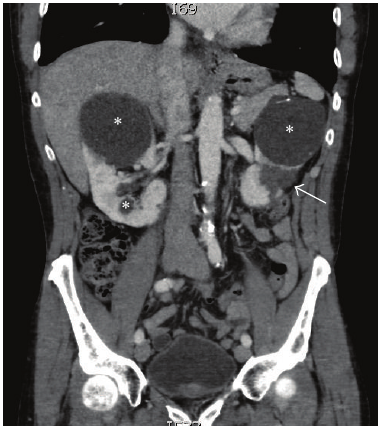
Figure 3: CT of the abdomen and pelvis with contrast, demonstrat- ing a wedge-shaped area of hypoenhancement in the mid to lower pole of the left kidney (arrow), consistent with infarct from septic embolization. Incidentally noted were the large, bilateral renal cysts ( ∗ ), unchanged in appearance from prior imaging.